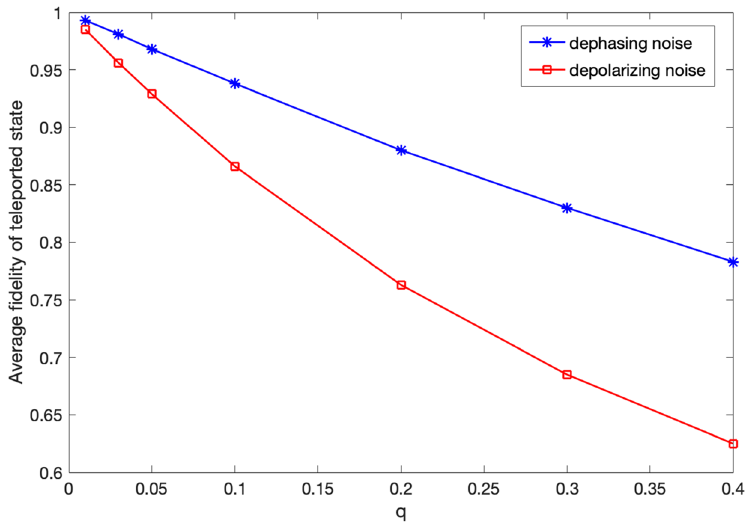
Figure 5. Average fidelity of the teleported state versus q